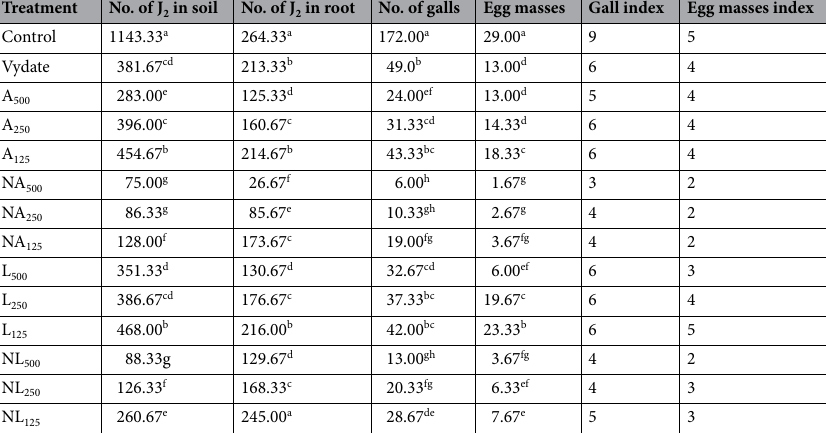
Table 7. Effects of A. annua and L. sativum extracts and their nano-formulations on the development of M. incognita in the root system of tomato plants. Means followed by the same letter(s) are not significantly (P < 0.05) different.